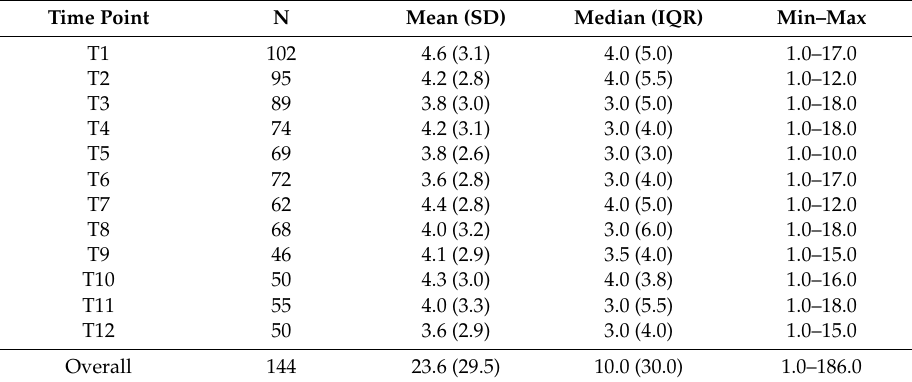
Table 2. Descriptive statistics of completed cognitive training modules in the study group.